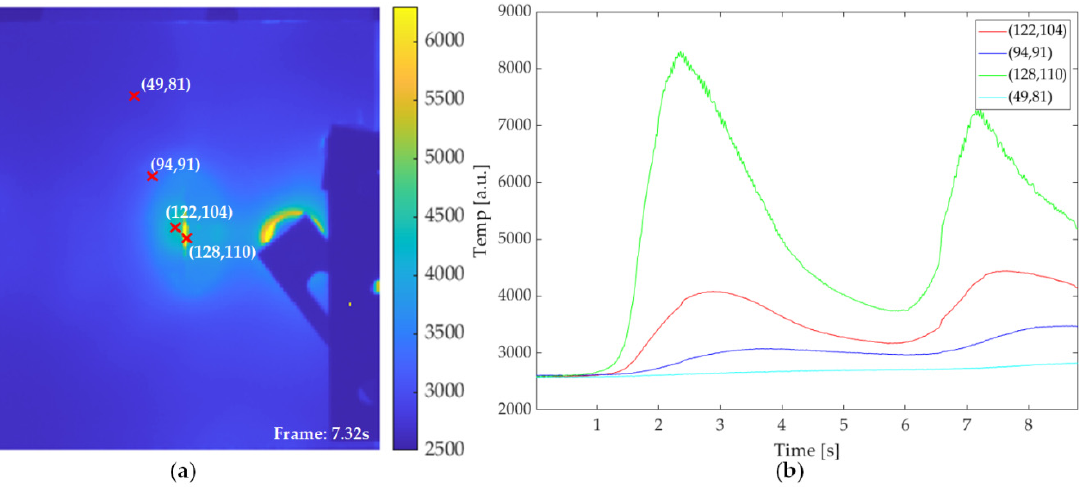
Figure 11. VT result on Al_G_60J sample: ( a ) pseudo color image of the first frame after two cycles of excitation; ( b ) temperature profile curve of the selected points.